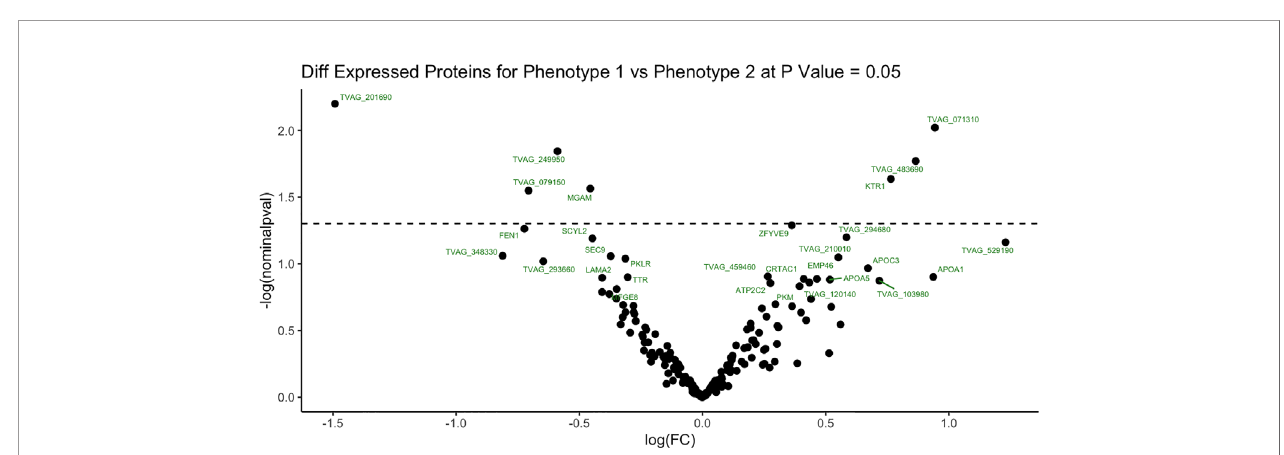
FIGURE 6 | Differentially expressed sEV proteins between virus-negative TV vs. virus-positive TV. Differential expression analysis compared log2-transformed abundance values of all sEV proteins identi fi ed between virus-negative TV vs. virus-positive TV. Dashed line represents p value = 0.05. X-axis represents log2- transformed fold change (FC). Y-axis represents -log2 transformed P